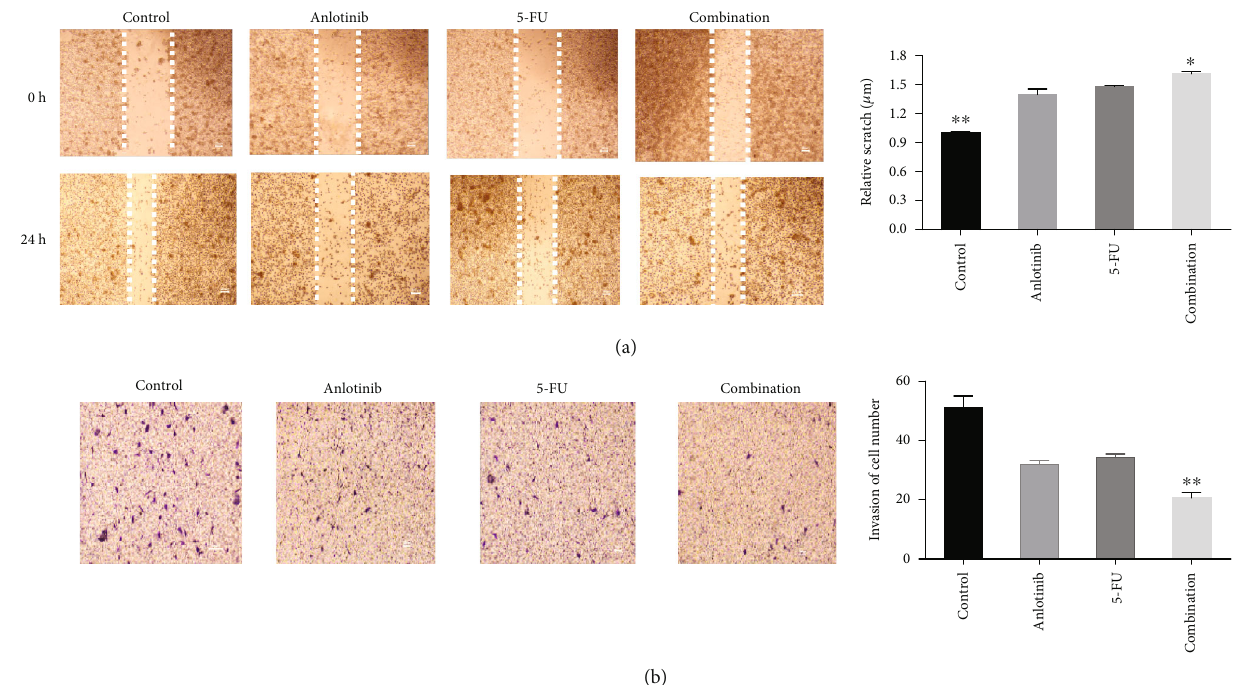
Figure 4: Anlotinib combined with 5-FU inhibits migration and invasion in the H446 cells. And the cells were fi xed in 20% paraformaldehyde and stained with 0.5% crystal violet. (a) The e ff ect of anlotinib (5 μ M) and 5-FU (10 μ M) or combination of both on cell migration evaluated by wound healing methods in the H446 cells. (b) The e ff ect of anlotinib (5 μ M) and 5-FU (10 μ M) or combination of both on cell invasion evaluated by transwell assays in the H446 cells. The results are from the three independent experiments. ∗ P < 0 : 05 and ∗∗ P < 0 : 01 compared with